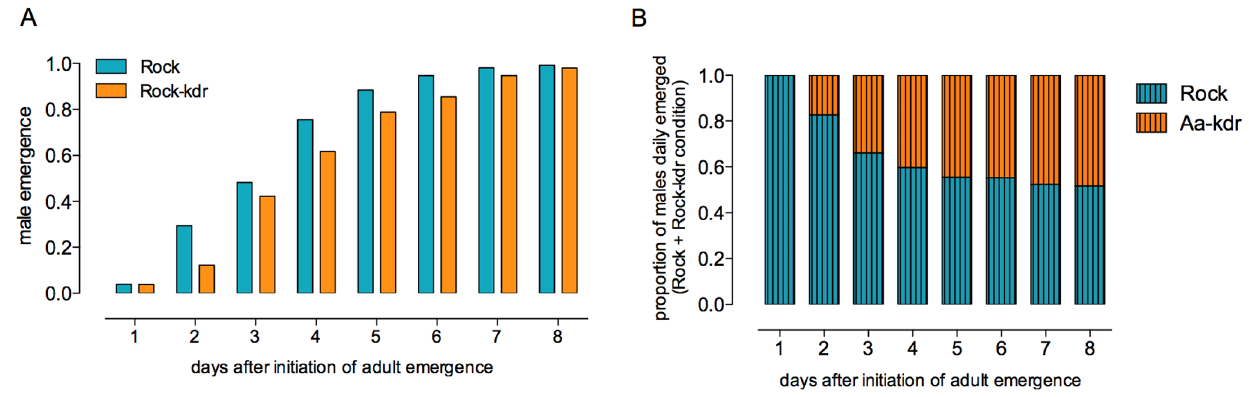
Figure 6. Developmental timing of Ae.aegypti Rock and Rock-kdr male adult emergence competing under a stringent condition. A – Cumulative rate of male emergence up to the 8th day after the beginning of adult emergence when the controls Rock and Rock-kdr were reared separately (‘intra-strain’ conditions). B – Cumulative proportion of Rock or Rock-kdr male emergence from the inter-strain competition. Male strain was daily determined by randomly genotyping 30% of emerging individuals.